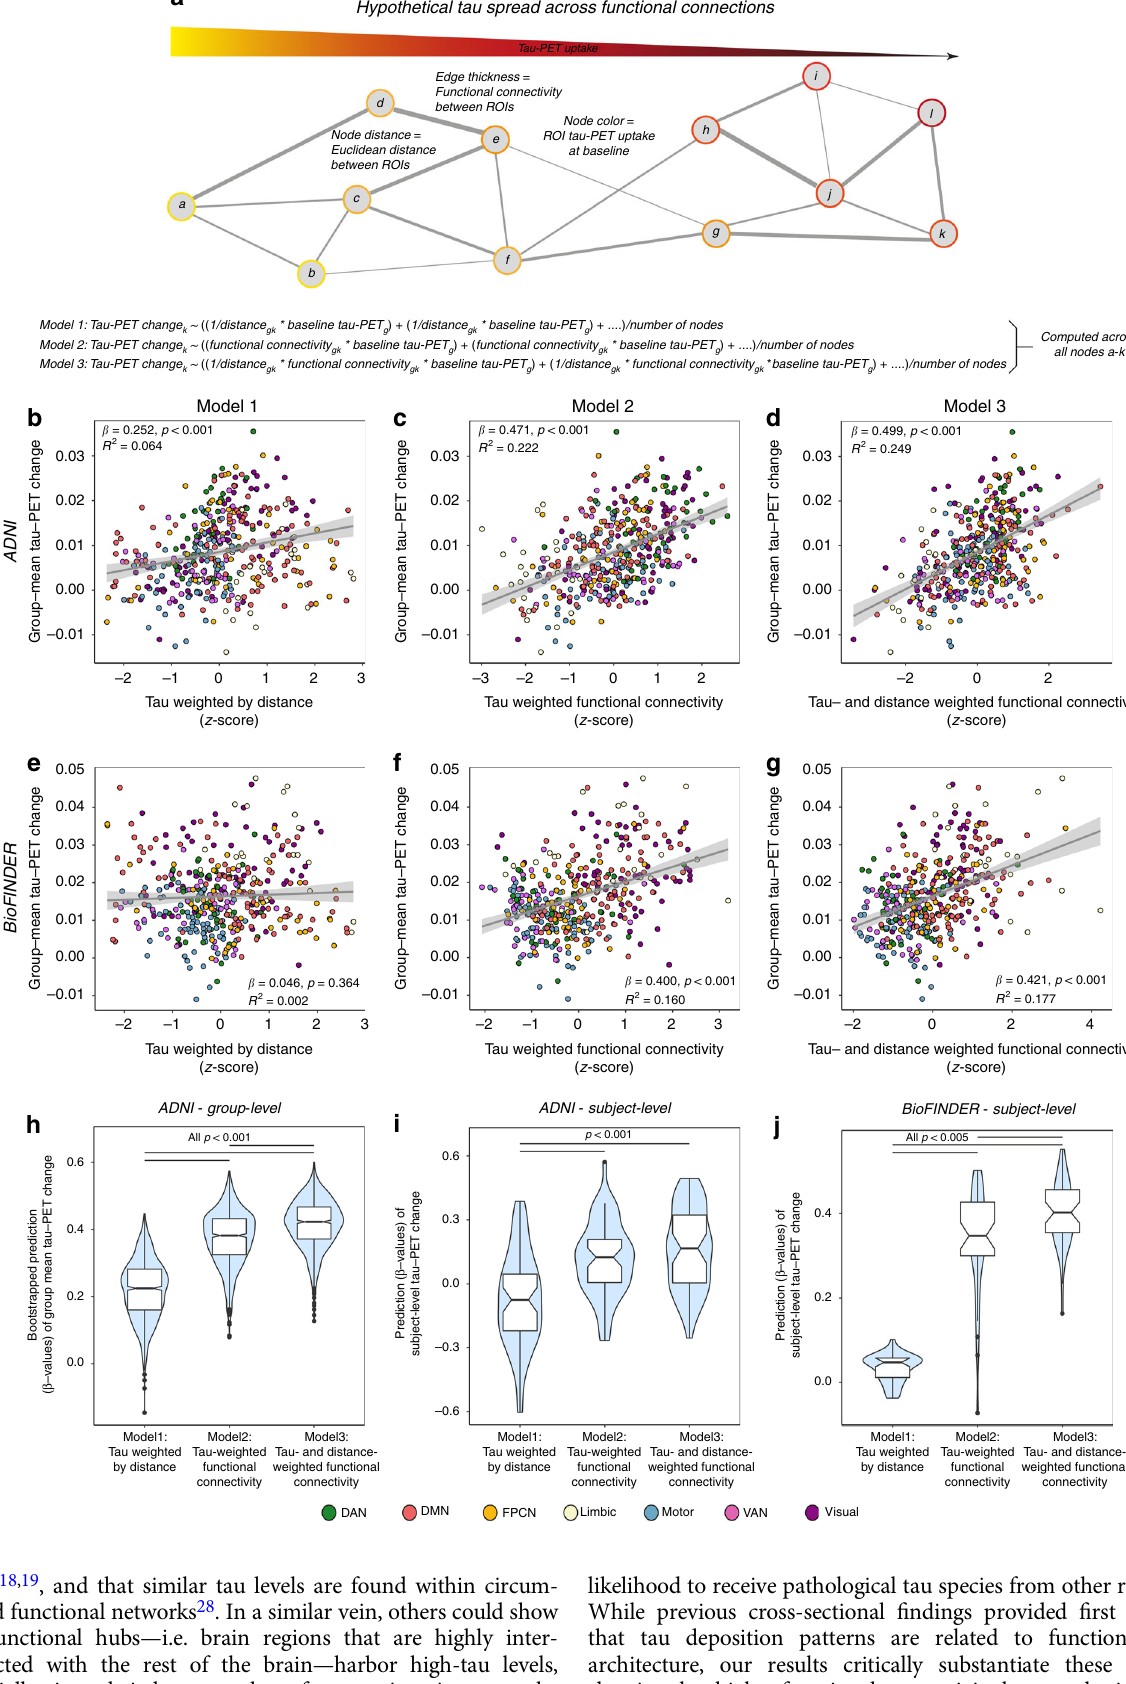
Model1: Tau weighted by distance